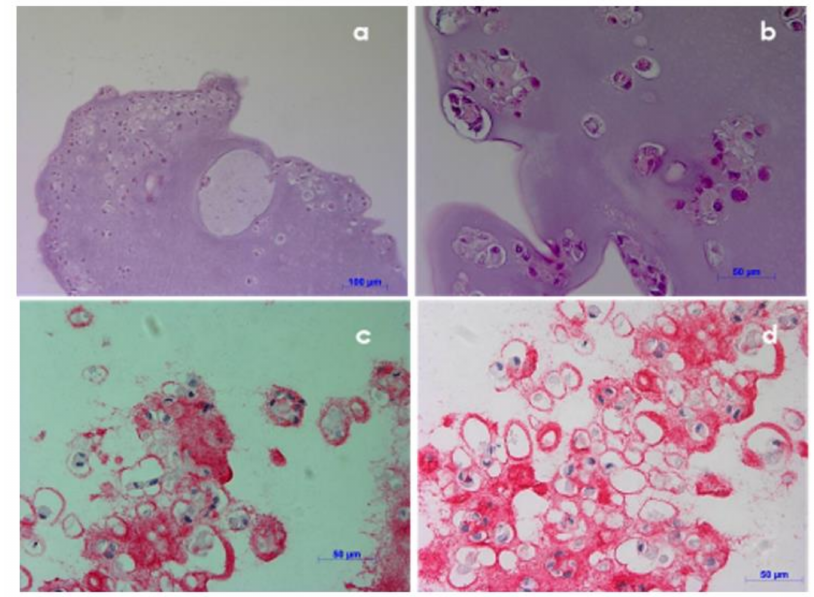
Figure 8. Histological evaluation of encapsulated NCs (beads model) after 35 days of culture post cryopreservation: Hematoxylin-eosin staining ( a , b ) and immunostaining for type II collagen (the phenotypic marker for chondrocytes) ( c , d